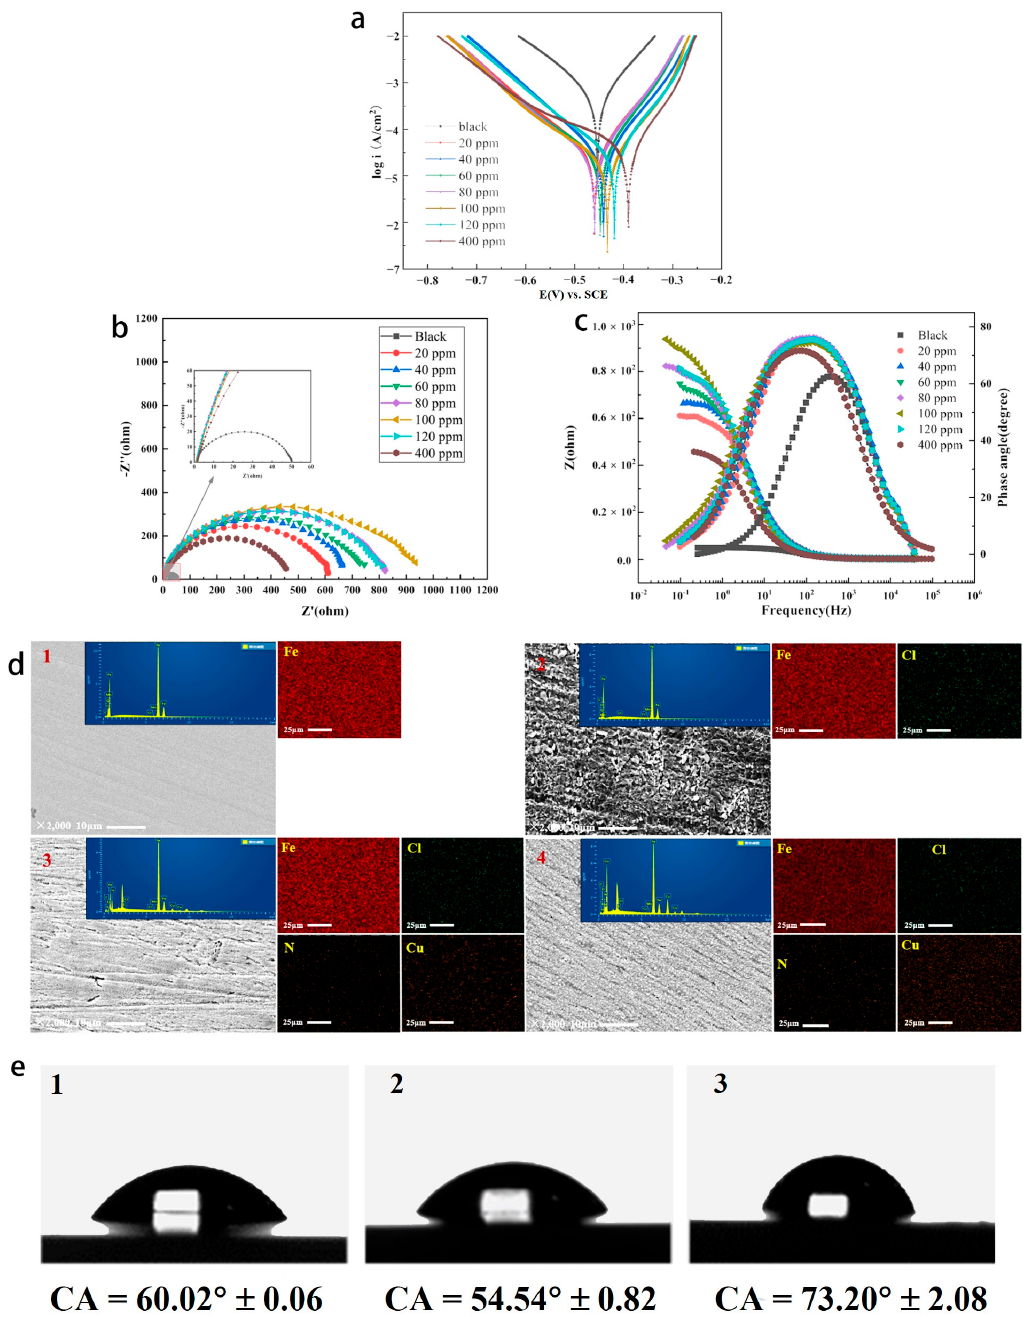
Figure 5. ( a ) Tafel curves of Q235 carbon steel in solutions containing different concentrations of Cu(II)@Thy-2; ( b ) Nyquist spectrum; ( c ) Bode-phase angle diagram; ( d ) SEM(10 µ m), EDS(25 µ m) and mapping of Q235 carbon steel surface: (1) Bare steel sheet; (2) 1 M HCl solution; (3) 100 ppm Cu( Ⅱ )@Thy-2; (4) 400 ppm Cu( Ⅱ )@Thy-2; ( e ) CA analysis of Q235 carbon steel metal surface: (1) Bare steel sheet; (2) 1 M HCl solution; (3) 100 ppm Cu( Ⅱ )@Thy-2 solution. Table 2. Tafel curves parameters of Q235 carbon steel in solutions containing di ff erent concentra- tions of Cu(II)@Thy-2.